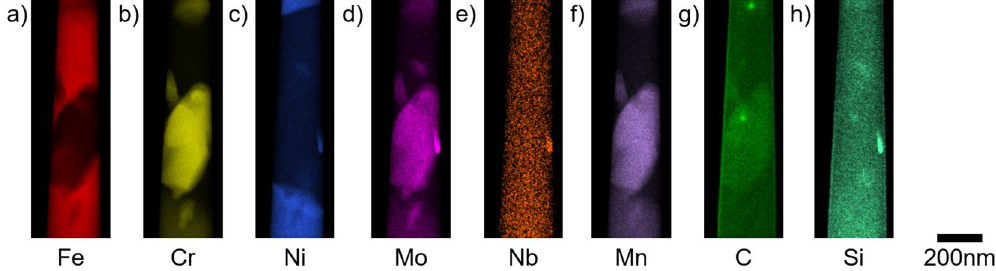
Figure 5. STEM-EDX elemental maps of the STEM needle displaying the intensity of X-ray counts associated with the ( a ) Fe K α , ( b ) Cr K α , ( c ) Ni K α , ( d ) Mo L α , ( e ) Nb K α , ( f ) Mn K α , ( g ) C K α and ( h ) Si K α peaks. The austenite phase at top and bottom is associated with Fe, Ni and to a lesser extent Mo and Mn, the ferrite phase is predominantly Fe with a small amount of Ni and Cr, the carbides contain Cr, Fe, Mo, C, Ni and Mn, the G-phase precipitate contains Nb, Ni, Mo and Si. The surface of the needle has high carbon and silicon intensities that are associated with organic contamination, primarily due to long exposure under the electron beam.